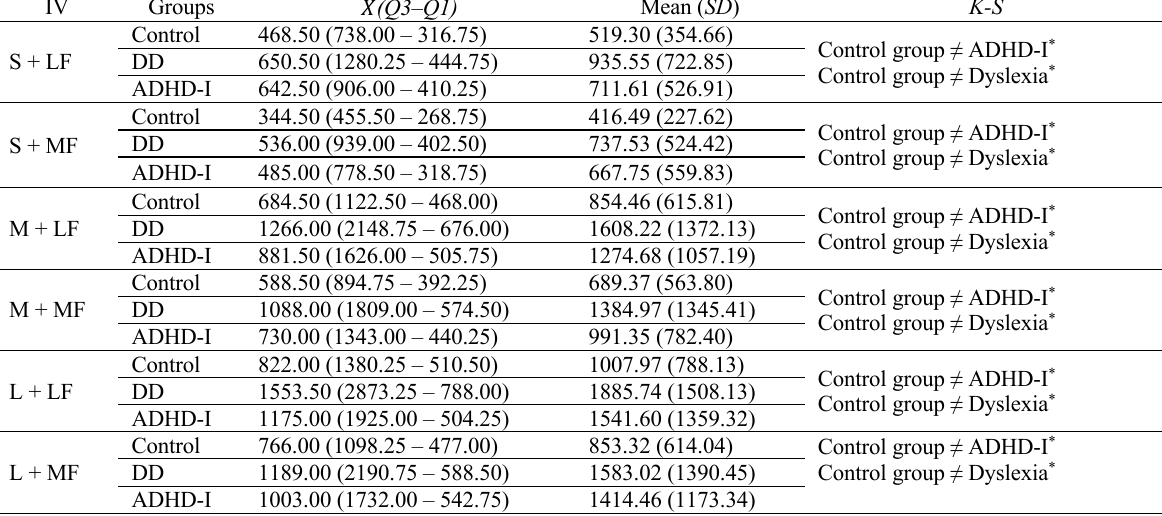
Table 9 – Median, 1 st and 3 rd percentiles, mean, standard deviation, and Kruskal-Wallis independent samples test: Total Fixation Time (in milliseconds) as a Function of Word Frequency and Word Length interaction in Dyslexia, Control and ADHD-I